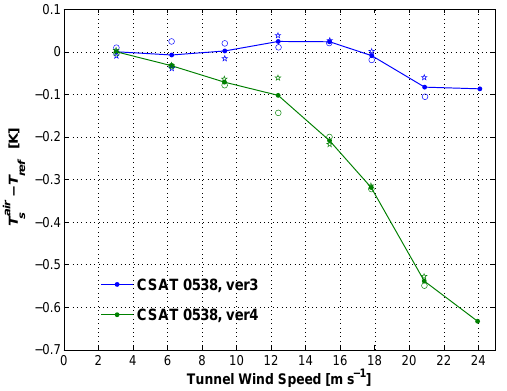
Fig. 7. The mean temperature difference ( T air s – T ref ) versus wind tunnel pitot tube wind speed. The CSAT 0538 air temperature ( T air s ) is calculated following Eq. (4) and uses either embedded code ver3 or ver4 (see legend). T ref is from a mechanically aspirated T/RH sensor (Sensirion, model SHT 75) located near the CSAT trans- ducer. Mean values were calculated over 20min at each tunnel wind speed. The temperature difference has been shifted so that the value at the lowest tunnel speed equals zero. Data were collected as tun- nel wind speed was increasing (stars) as well as decreasing (open circles), and the solid line is the mean value at each wind